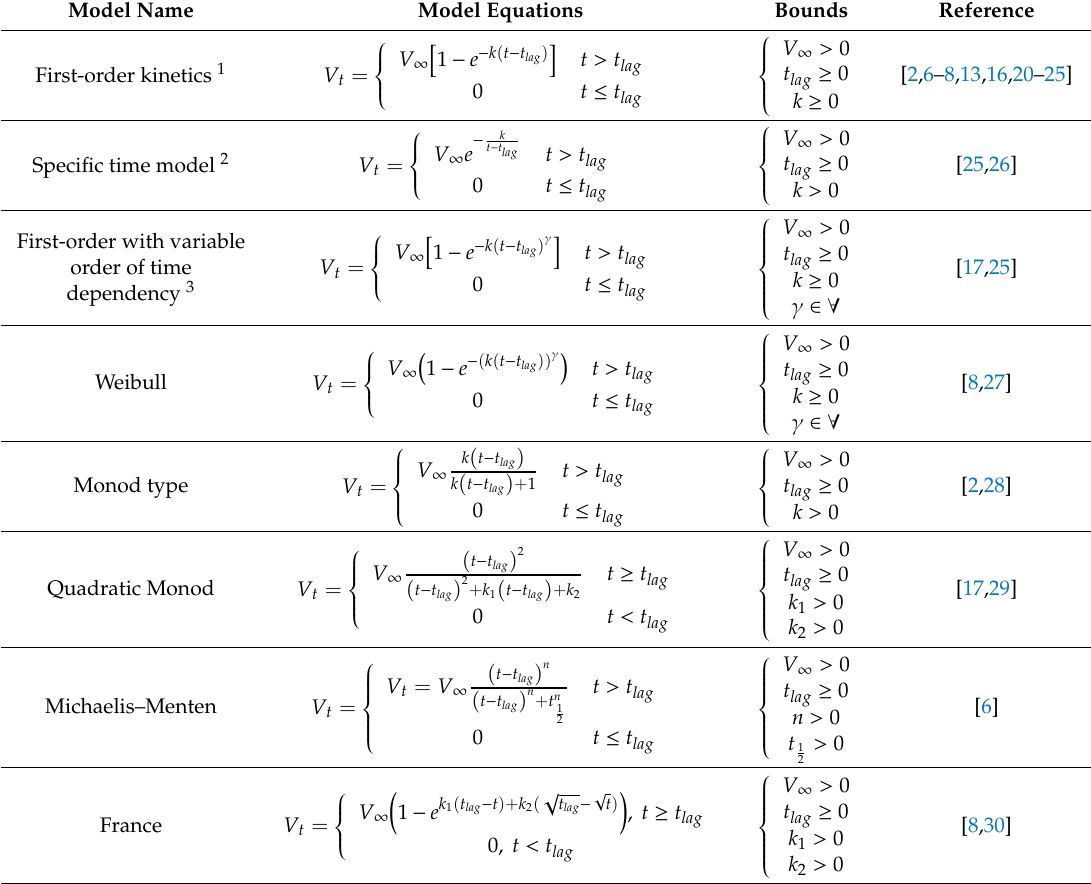
Table 1. Interpretation of biomethane formation models for numerical fitting for single-step